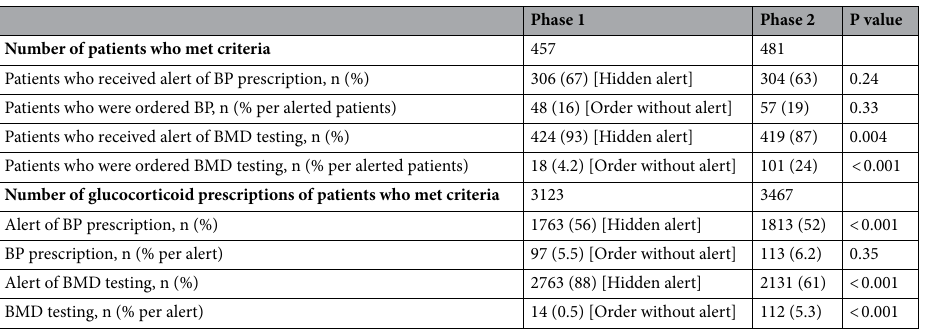
Table 2. Alerts from computerized clinical decision support system. BP bisphosphonates, BMD bone mineral